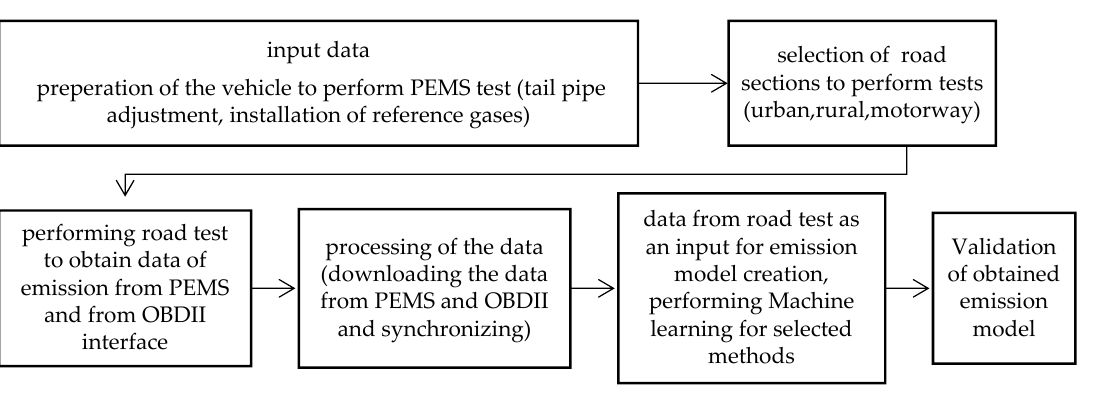
Figure 1. Flow chart of research.